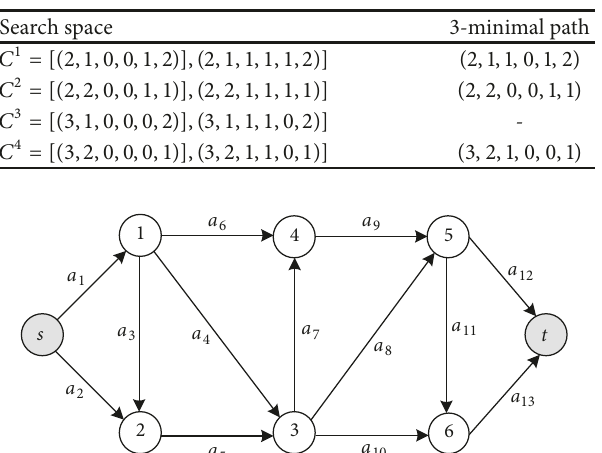
Figure 2: A benchmark network for numerical experiments.